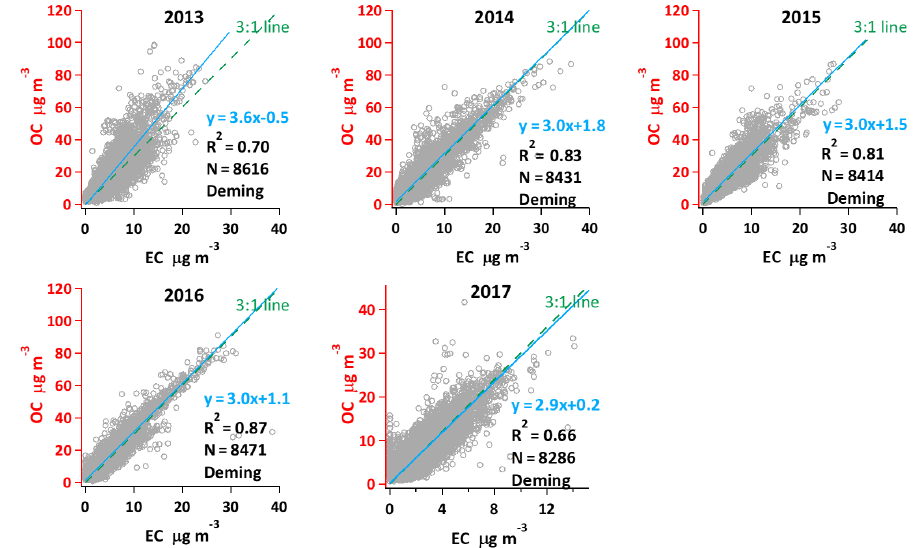
Figure 5. Relationship between OC and EC using the Deming regression method from 2013 to 2017 (the dashed line indicates a OC / EC ratio of 3 :